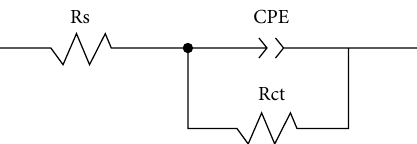
Figure 7: Equivalent electrical circuit corresponding to the corrosion process on the carbon steel in hydrochloric